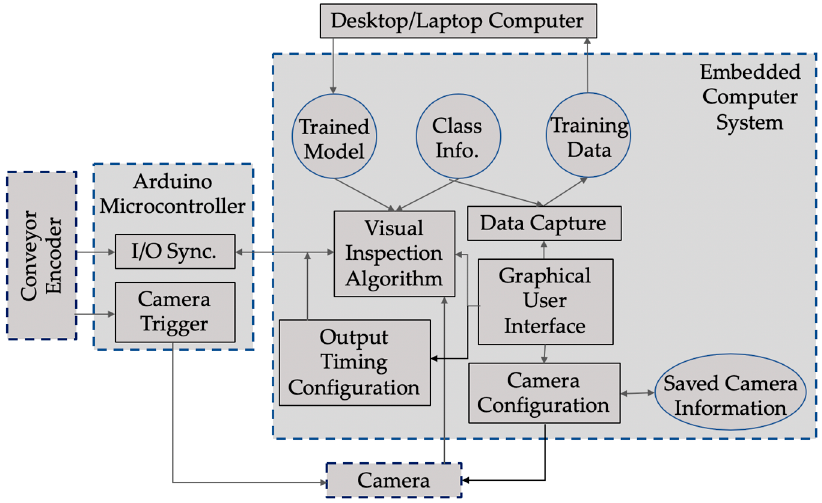
Figure 5. Software / hardware system diagram. Figure 5. Software/hardware system diagram. Figure 5. Software/hardware system diagram.